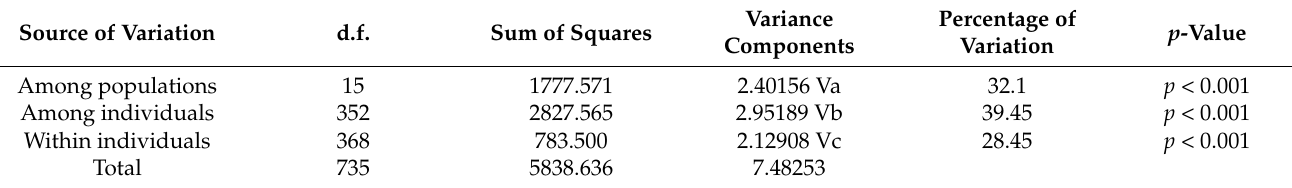
Table 2. The analysis of molecular variance (AMOVA) for P. persica